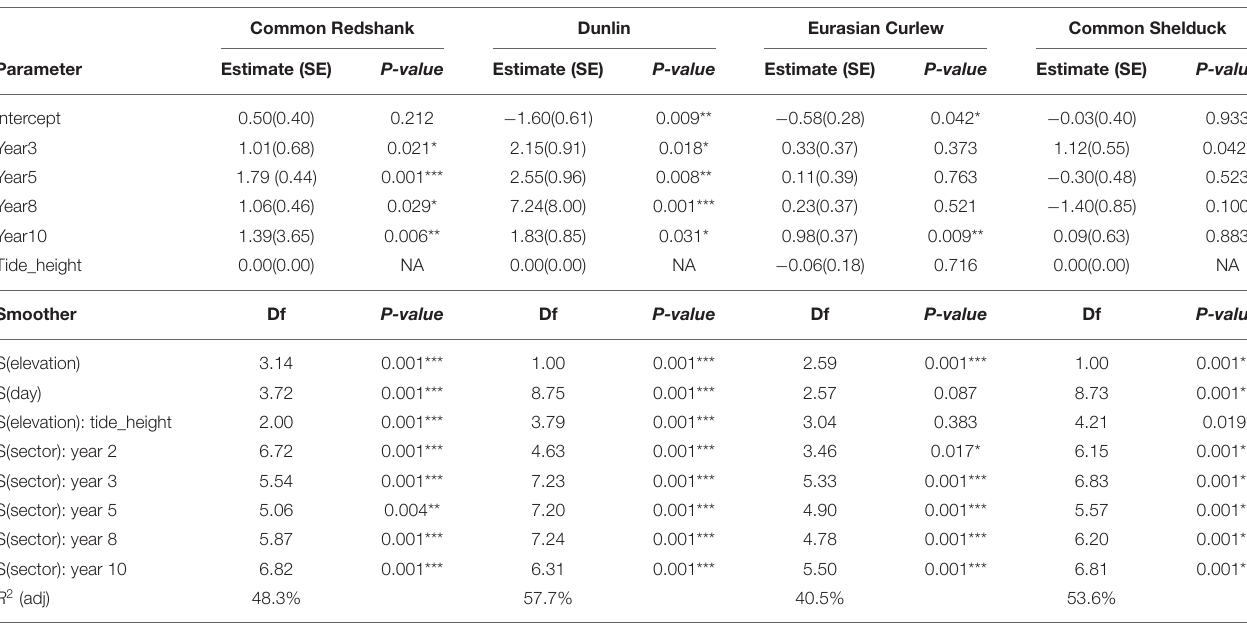
TABLE 3 | Model results for the four key compensatory target species. Common Redshank Dunlin Eurasian